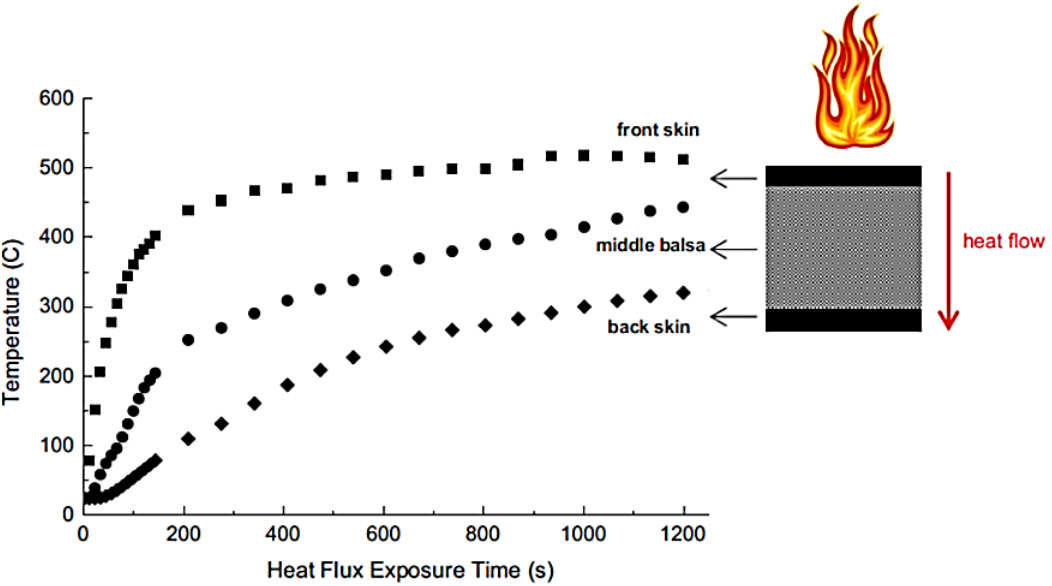
Figure 2. Temperature – time profiles at front (heated) laminate face sheet, middle of balsa core, and back face sheet of sandwich structure exposed to thermal flux representative of fire [41]. Reproduced with permission from Elsevier.